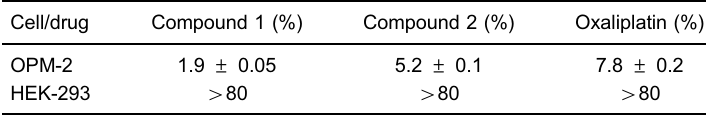
Table 3. Half inhibitory concentration values of compounds 1 and 2, and oxaliplatin against OPM-2 cancer cells and normal human HEK-293 cells